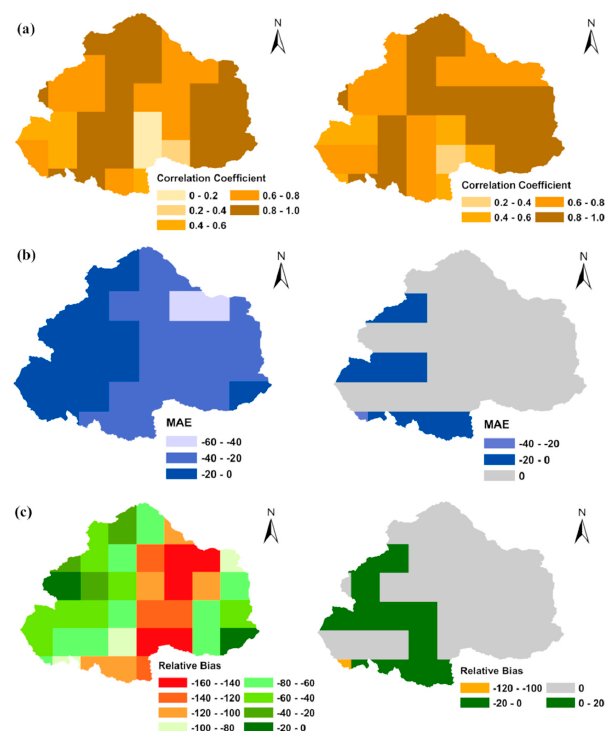
Figure 11. Spatial plot of performance evaluation parameters namely ( a ) correlation coefficient ( r ) ( b ) MAE and ( c ) RBIAS, before (left) and after (right) bias correction of TRMM precipitation for the post-monsoon season.